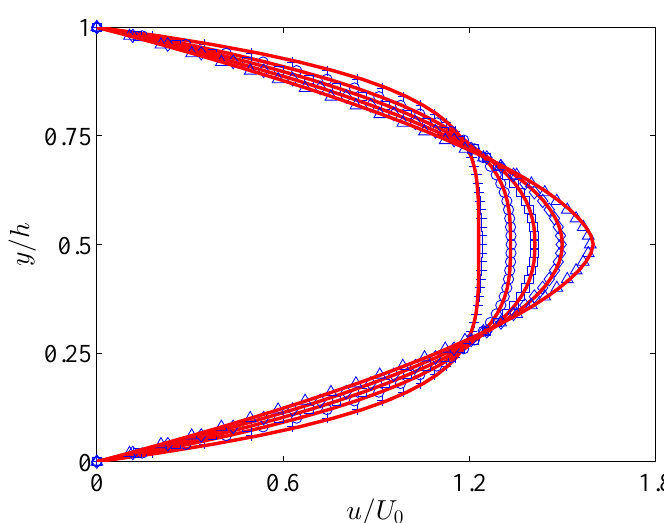
Figure 2. Velocity profiles of the fully developed flow in a channel predicted by the present numerical method (markers) and those calculated by Equation (25) (solid lines), at Re = 10 and n = 0.3 (+), 0.5 (o), 0.7 ( (cid:3) ), 1.0 ( ♦ ), and 1.5 ( ∆ ).